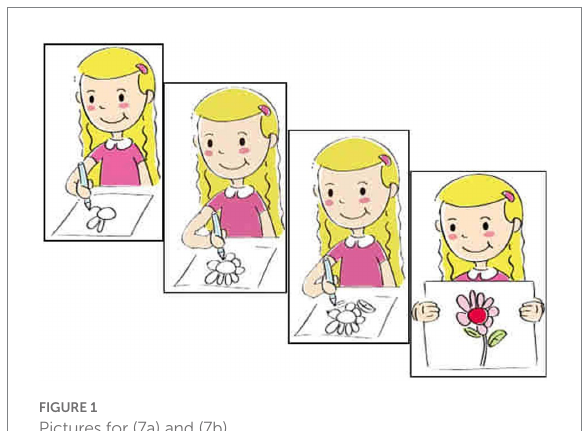
FIGURE 1 Pictures for (7a) and